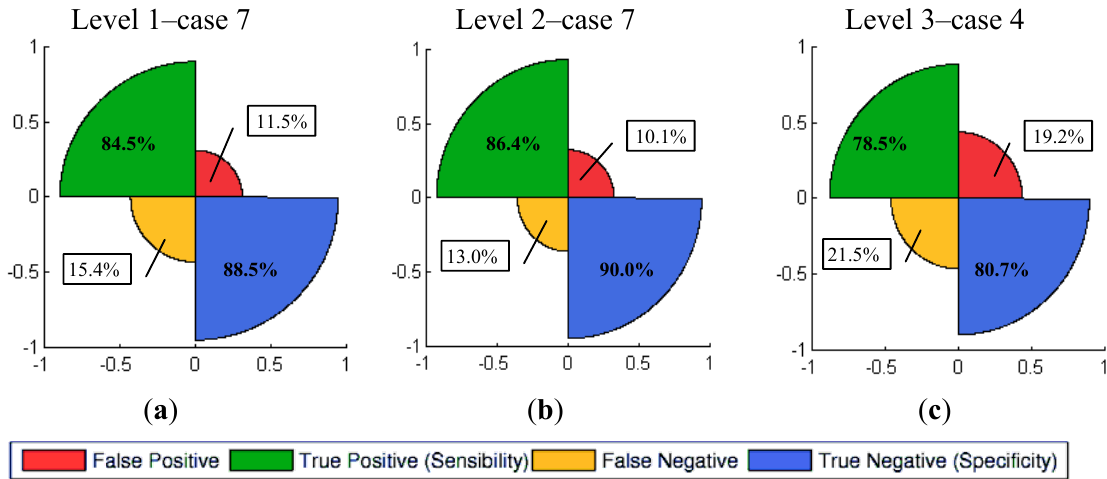
Figure 12. Summative method ( Σ ) rose plots ( a ) Level 1-case 7 (Table 4); ( b ) Level 2-case 7 (Table 5); ( c ) Level 3.